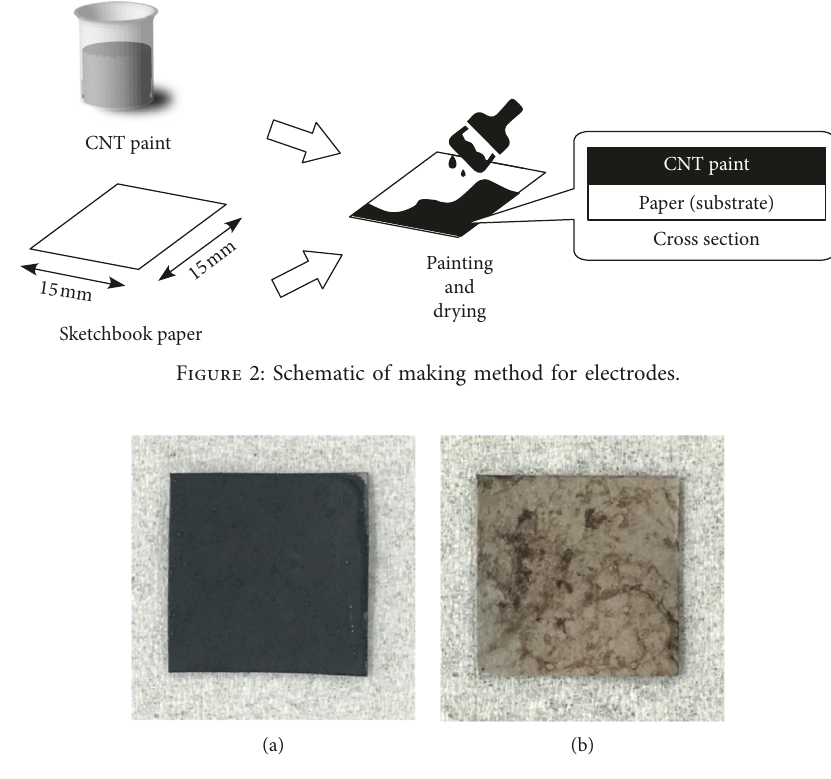
Figure 3: (a) Metallic electrode obtained by painting our metallic CNT paint and (b) semiconducting electrode obtained by painting our semiconducting CNT paint. Both electrodes have area of 15 by 15mm 2 .